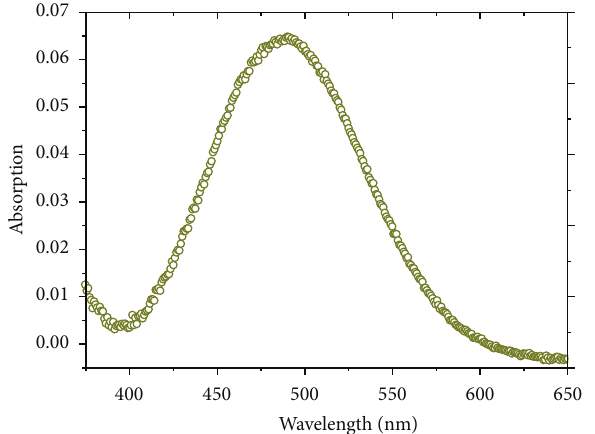
Figure 2: Absorption spectrum of N,N 󸀠 -diphenylbenzene-1,4- diamino-1,8-naphthalic anhydride derivative.